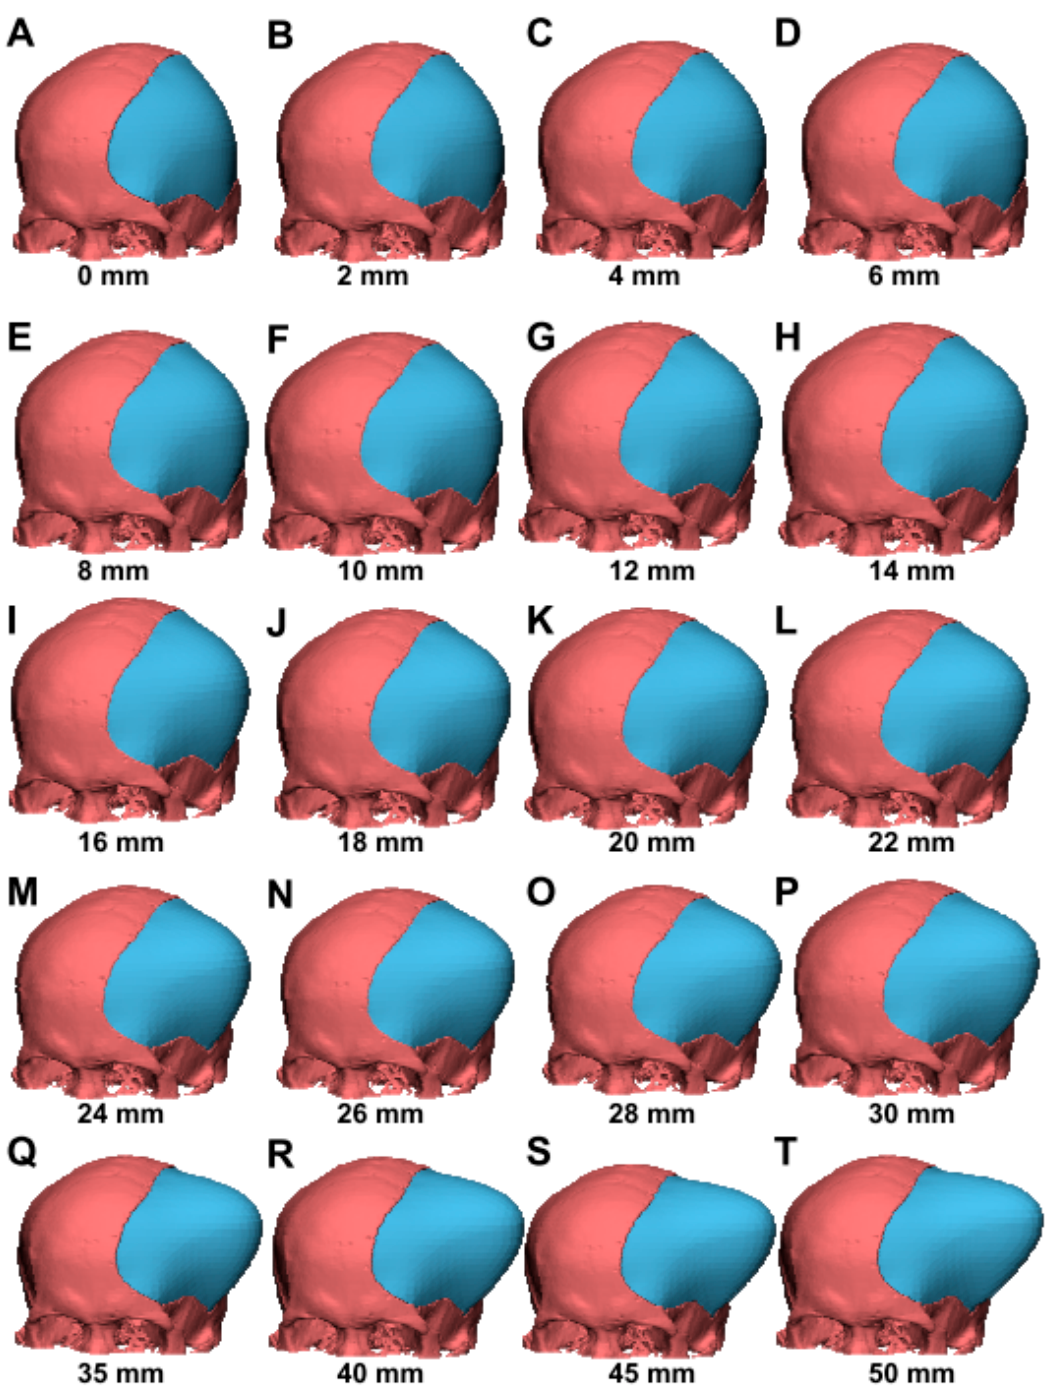
Figure 3. Various 3D CAD models with an elevated contour from 2–50 mm (case 3). The CAD model included algorithms for contour elevation, mimicking scalp outward bulging and, therefore, creating additional extracranial space for accommodation of brain swelling. ( A – T ) The 2–50 mm contour elevations represent various extents of volume expansion.